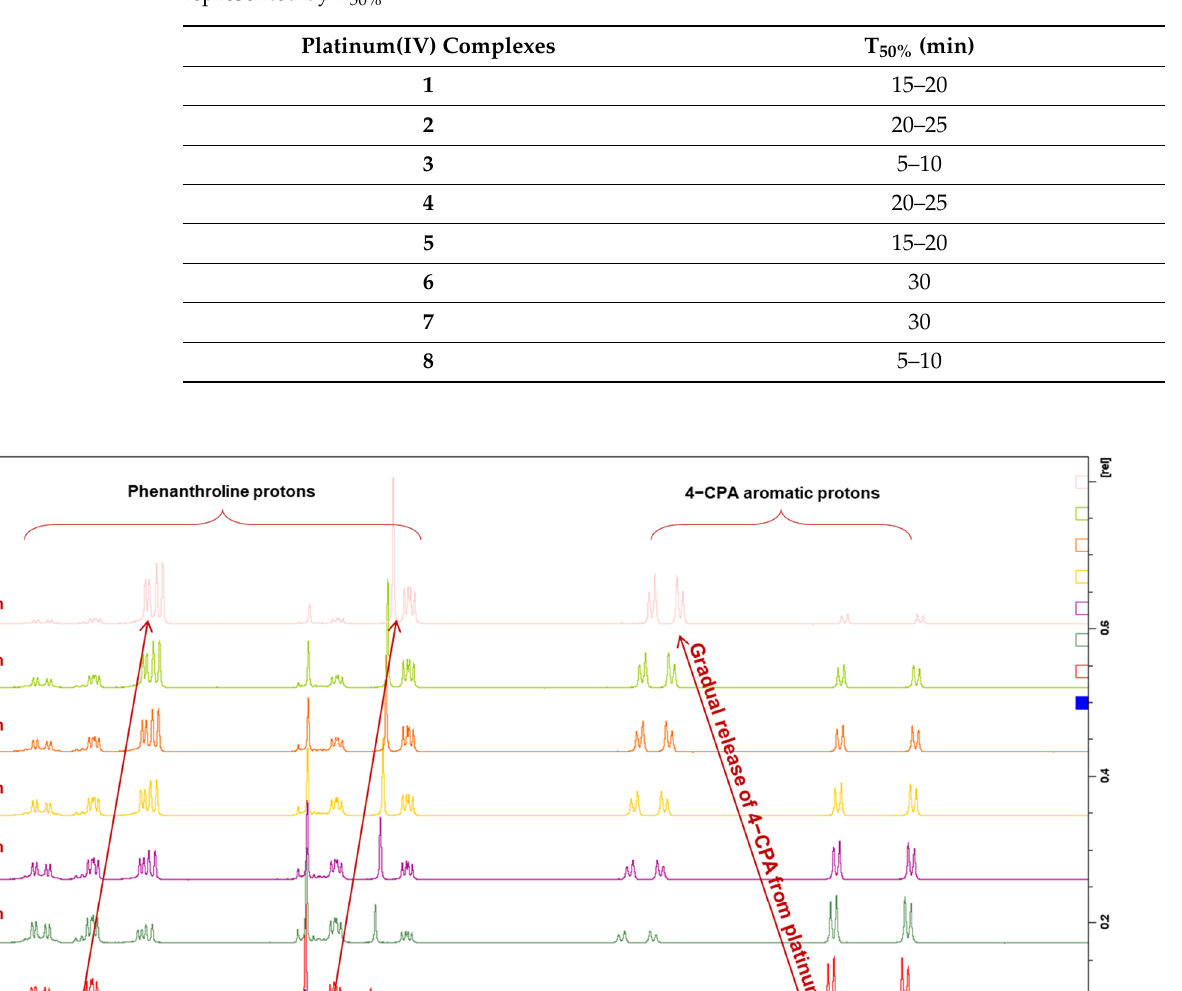
Table 6. A summary of approximate time points in min for 1 – 8 at which 50% reduction occurs as represented by T 50% .